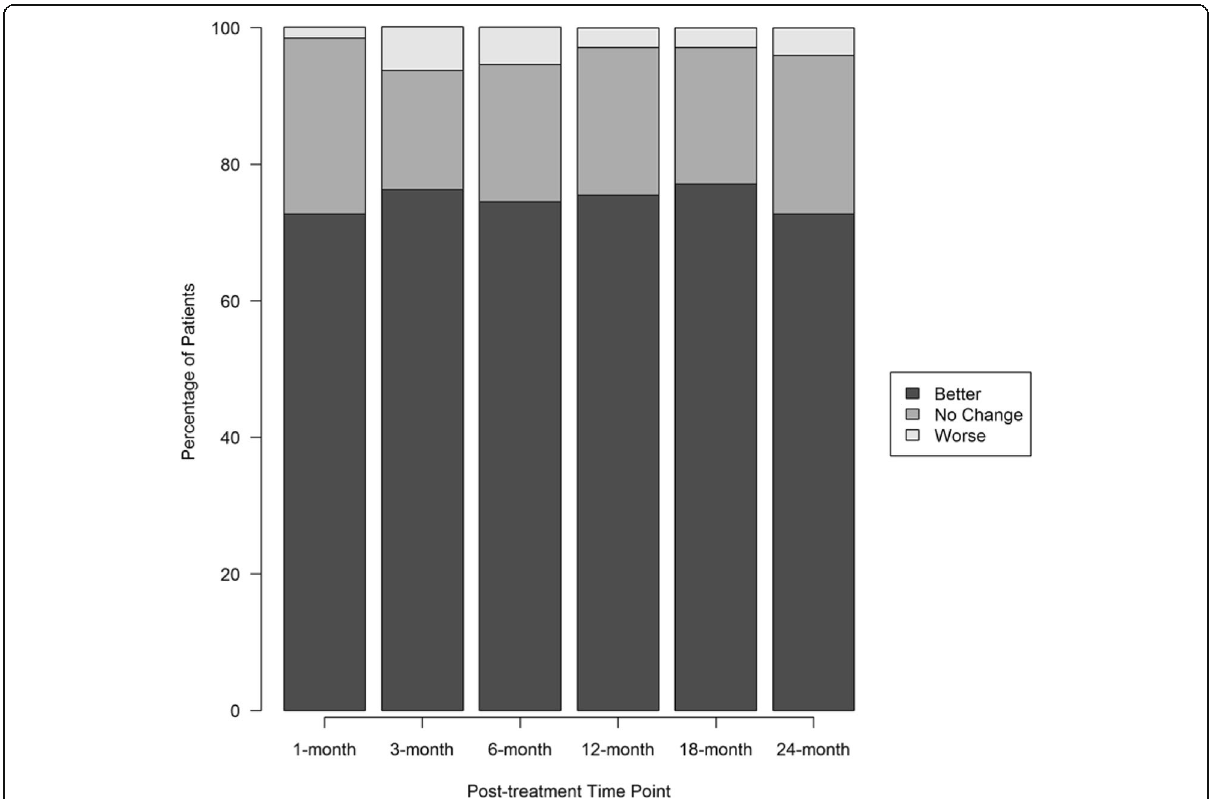
Fig. 4 Modified SANE ratings tier plot. The percent of total patients at each post-treatment time point reporting feeling better (modified SANE > 0), no change (modified SANE = 0), or worse (modified SANE < 0). Patients reporting at each time point: 1- month ( N = 128); 3-month ( N = 211), 6-month ( N = 216), 12-month ( N = 203), 18-month ( N = 153), 24-month ( N =